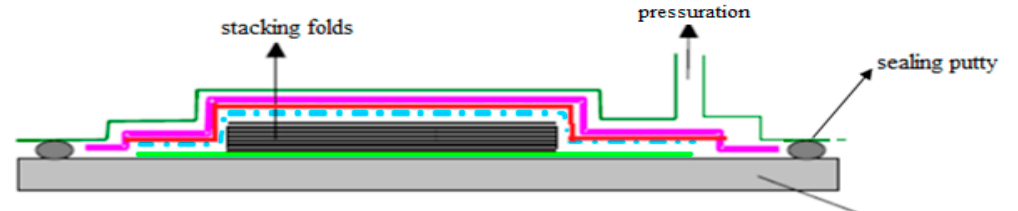
Figure 2. Vacuum moulding process. Figure 2. Vacuum molding